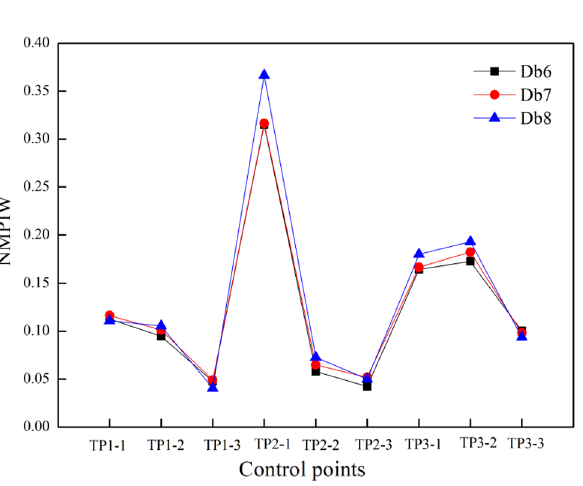
Figure 8. NMPIW value of PIs with Db6, Db7 and Db8 wavelets at different control